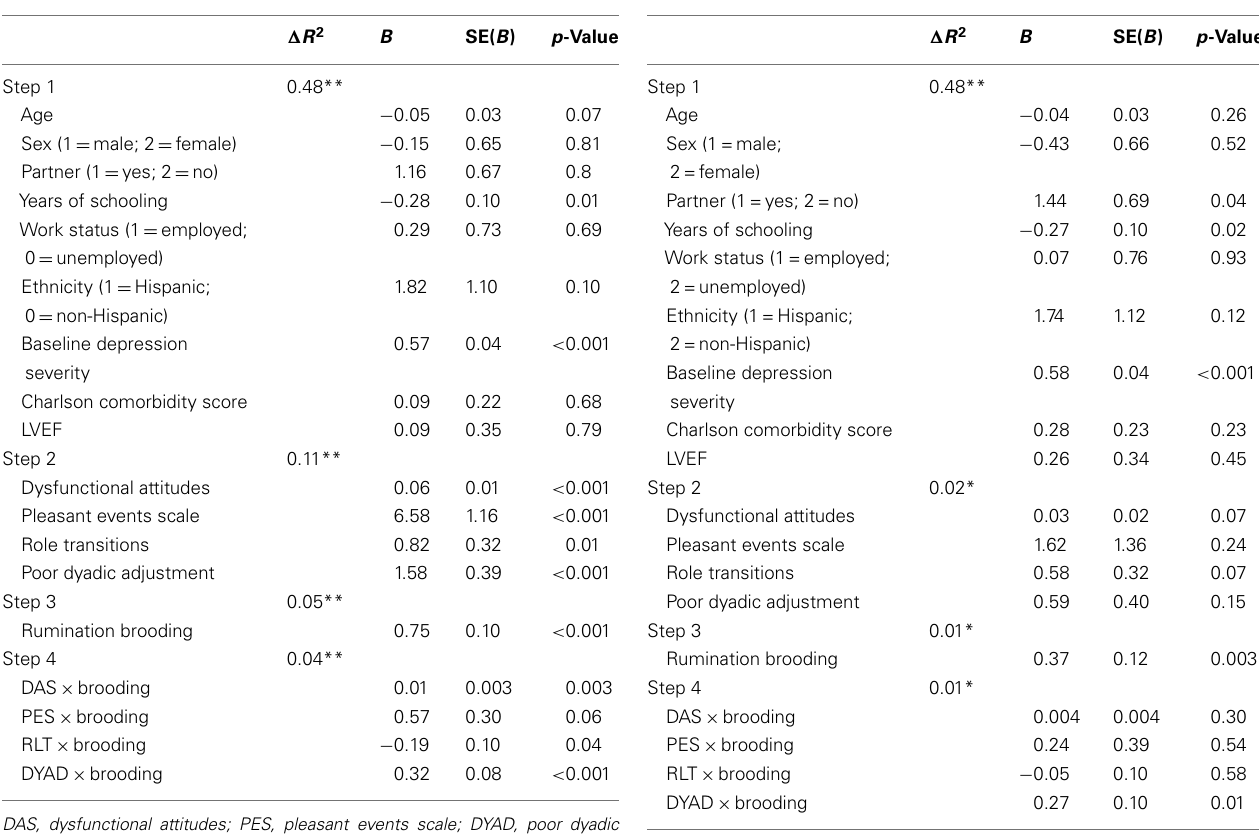
Table 3 | Hierarchical regression summary of the effect of psychosocial vulnerabilities at 3months, rumination as an independent predictor and rumination as an amplifier on 3month depression severity, post-ACS.